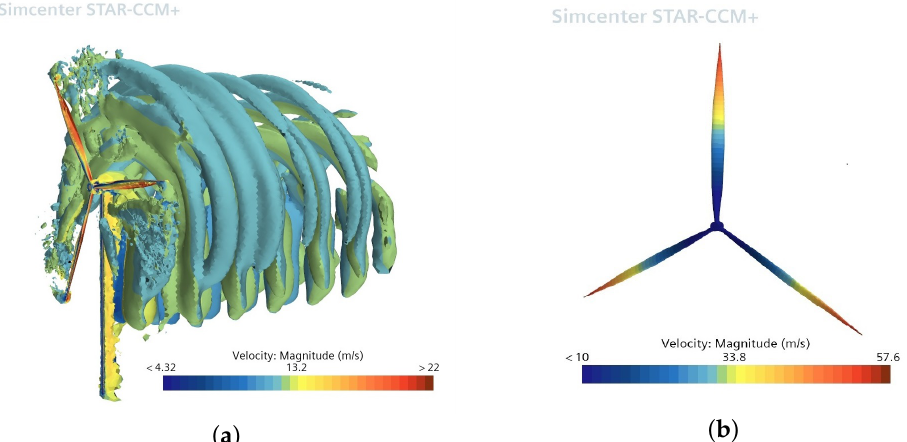
Figure 8. Research results: ( a ) wake behind the wind turbine, ( b ) velocity distribution on the blades of the wind